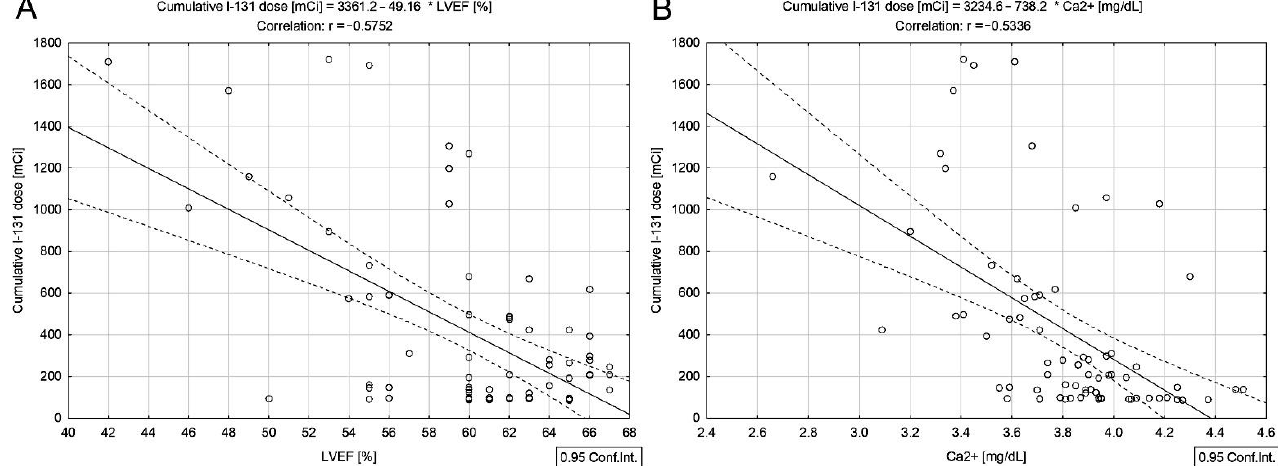
Figure 1. Correlations between the cumulative dose of 131 I and LVEF ( A ), serum concentrations of Ca 2+ ( B ) in differentiated thyroid cancer patients without type 2 diabetes mellitus. Moreover, the cumulative dose of 131 I was negatively correlated with absolute lym- phocyte count ( r = − 0.58, p < 0.001) (Figure 2A) and positively with NLR and PLR ( r = 0.57 and r = 0.46, p < 0.001) (Figure 2B,C). No correlation between the cumulative 131 I dose and the serum concentrations of total cholesterol, lipids, triglycerides, and ALP was noticed.